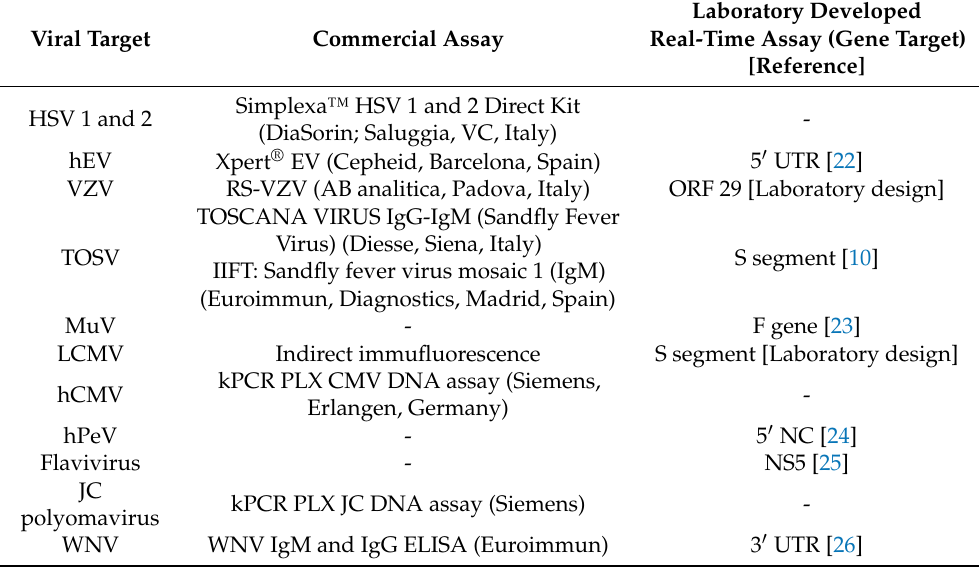
Table 1. Assays for the detection of VME in Hospital Virgen de las